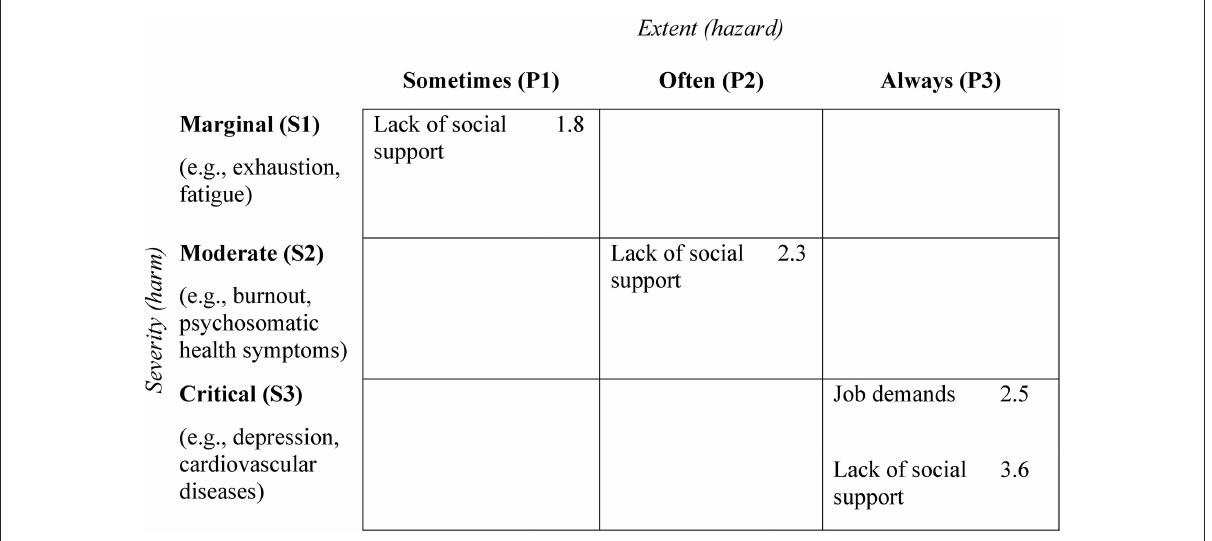
FIGURE4 Example of a risk matrix with fictional data for the selection of risk-mitigating measures. The values represent averaged odds ratios between the measured hazards and all health-related outcomes within one